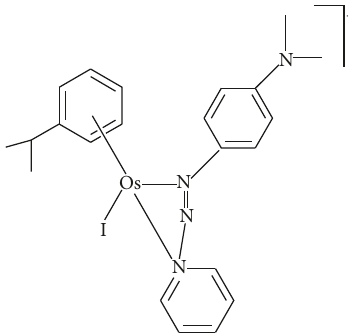
Figure 6: Osmium(II) arene anticancer complex with phenyl- azopyridine ligands.